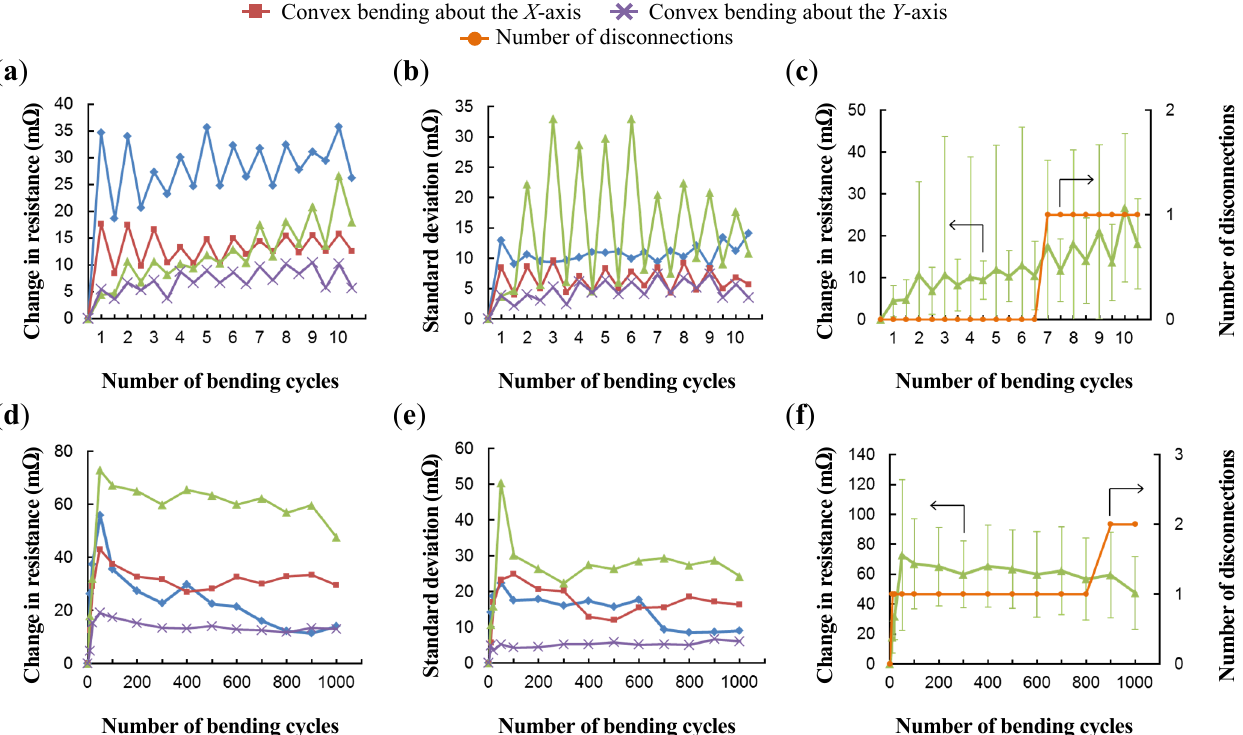
Figure 14. Change in resistance during the bending test for a curvature radius of 10 mm: ( a – c ) continuous measurements; ( d – f ) intermittent measurements; and ( c , f ) concave bending about the Y -axis.